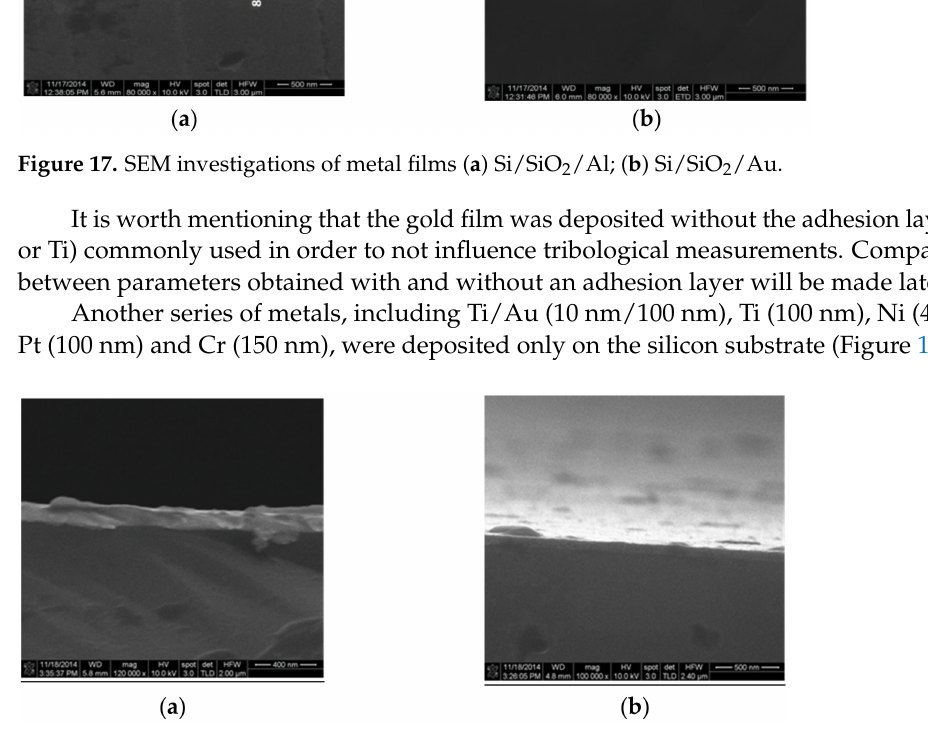
Figure 18. SEM investigations of metal films ( a ) Si/Ti/Au; ( b ) Si/Ni. A treatment applied to the substrate of the Si/SiO 2 samples was thermal oxidation with the purpose of increasing the 90 nm thin film. The reaction between dichlorosilane (SiCl 2 H 2 ) and ammonia (NH 3 ) led to the silicon nitride (Si 3 N 4 ) that was used to deposit the Si/Si 3 N 4 samples. Using the technique of thermal wet oxidation, a thick silicon oxide (with 1.7 µ m thickness) was grown for the Si/SiO 2 /PolySi samples. Finally, a polysilicon layer resulted from using the LPCVD technique was deposited from silane (SiH 4 ) decomposition. Two different temperatures (580 and 630 ◦ C) were used in the LPCVD deposition